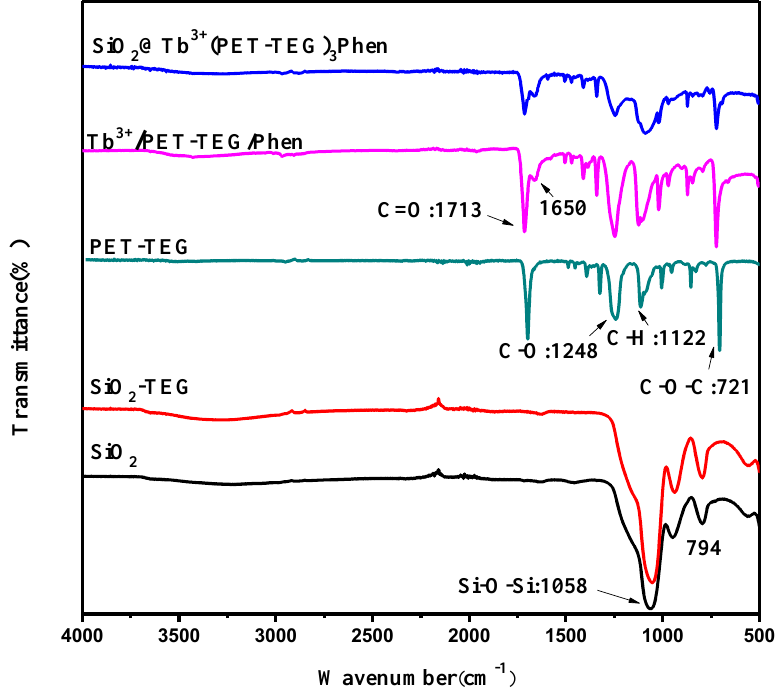
Figure 1. Fourier transform infrared (FTIR) spectra of SiO 2 , SiO 2 –tetraglycol (TEG), SiO 2 @Tb 3 + (poly(ethylene terephthalate)–TEG) 3 phenanthroline (SiO 2 @Tb 3 + (PET–TEG) 3 Phen), PET–TEG, and Tb 3 + / PET–TEG /